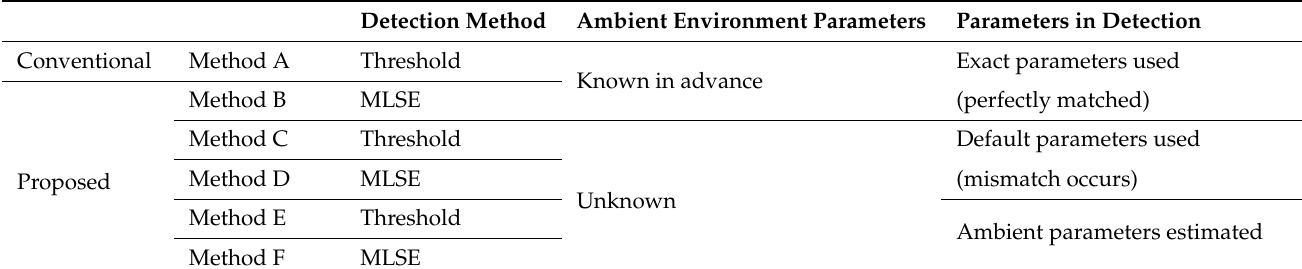
Table 3. Summary of demodulation methods.